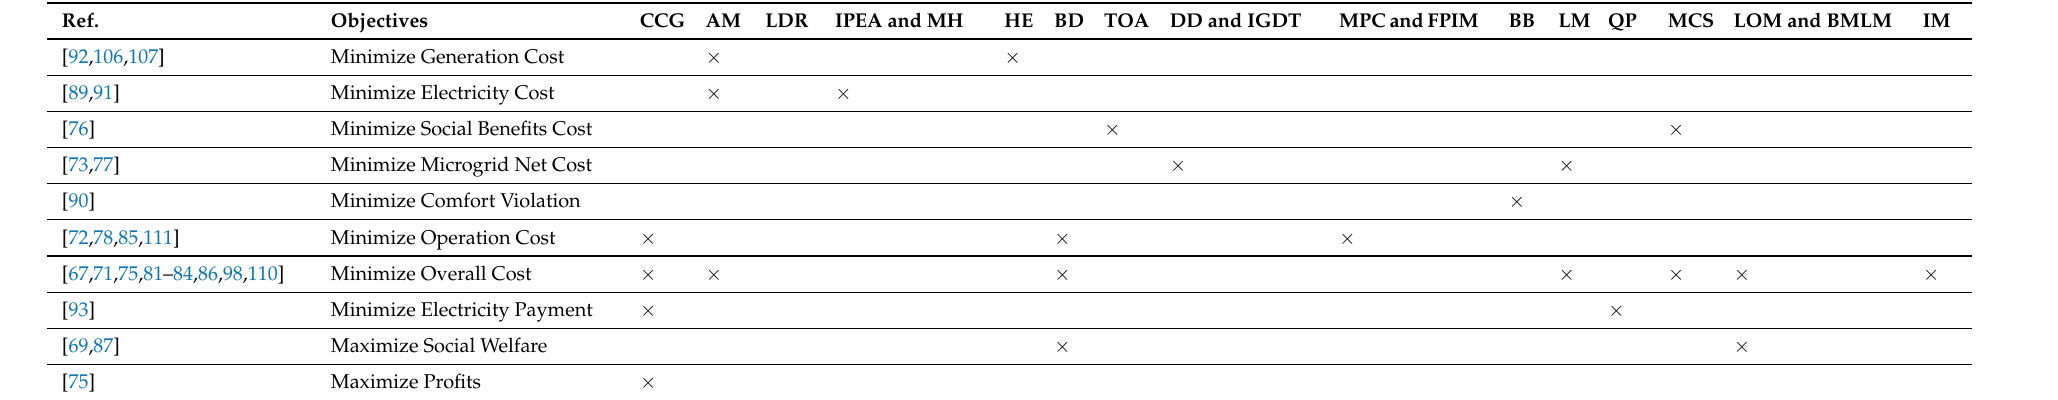
Table 4. Objectives of robust optimization and its solution